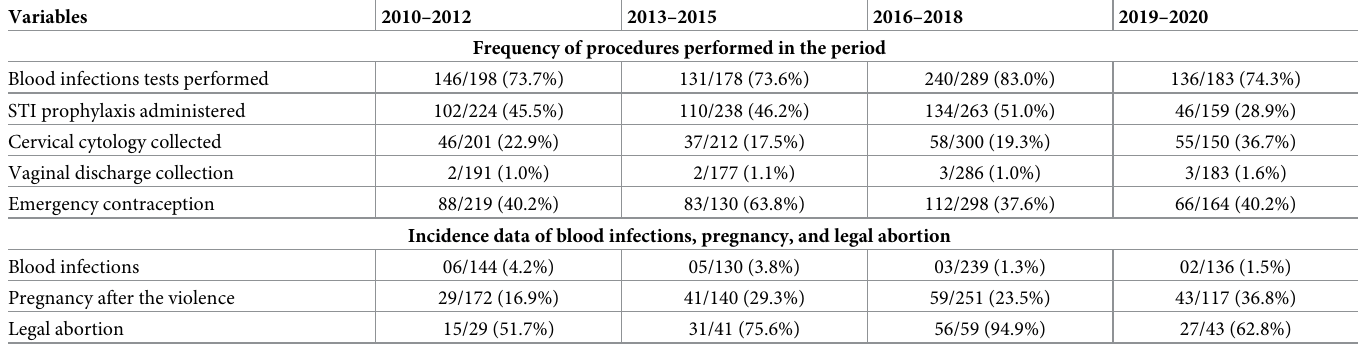
Table 5. Frequencies of performed clinical procedures and the incidence of blood-borne infections, pregnancies, and legal abortions, by period, in women in sexual violence situations assisted by PAVI´VIS between 2010 and 2019.